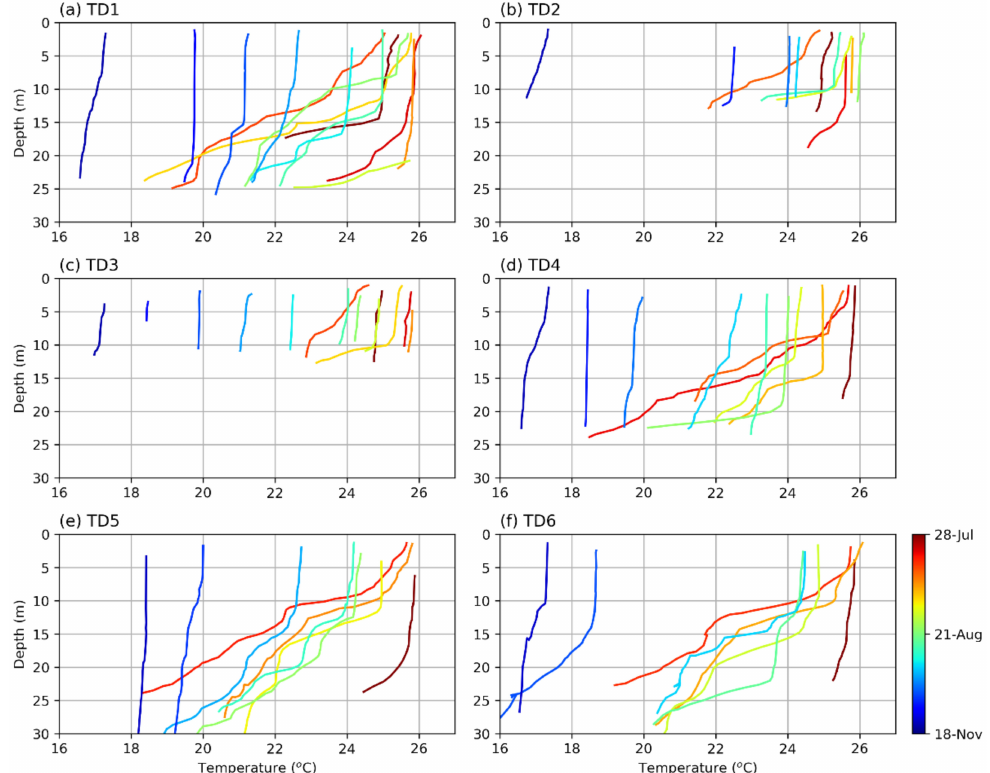
Figure 10. Temperature profiles ( a – f ) are colored as a function of time. Note that the start and end dates for stations ( a – c ) (top color bar) are not the same as for stations ( d – f ) (bottom color bar). The reader is referred to Table 4 for the exact sampling